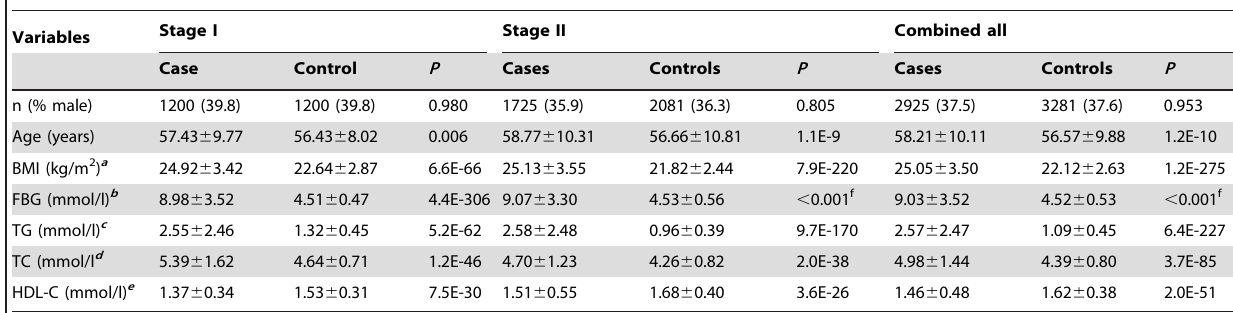
Table 1. Characteristics of the study populations.